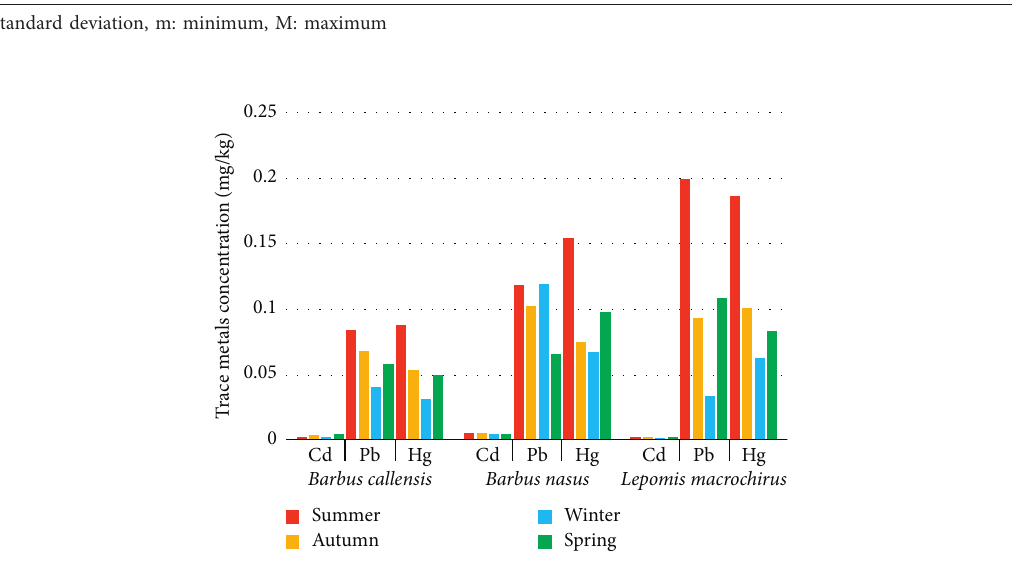
Figure 3: Seasonal variation in mean trace metals concentrations in muscles of the three fish species (mg/kg of wet